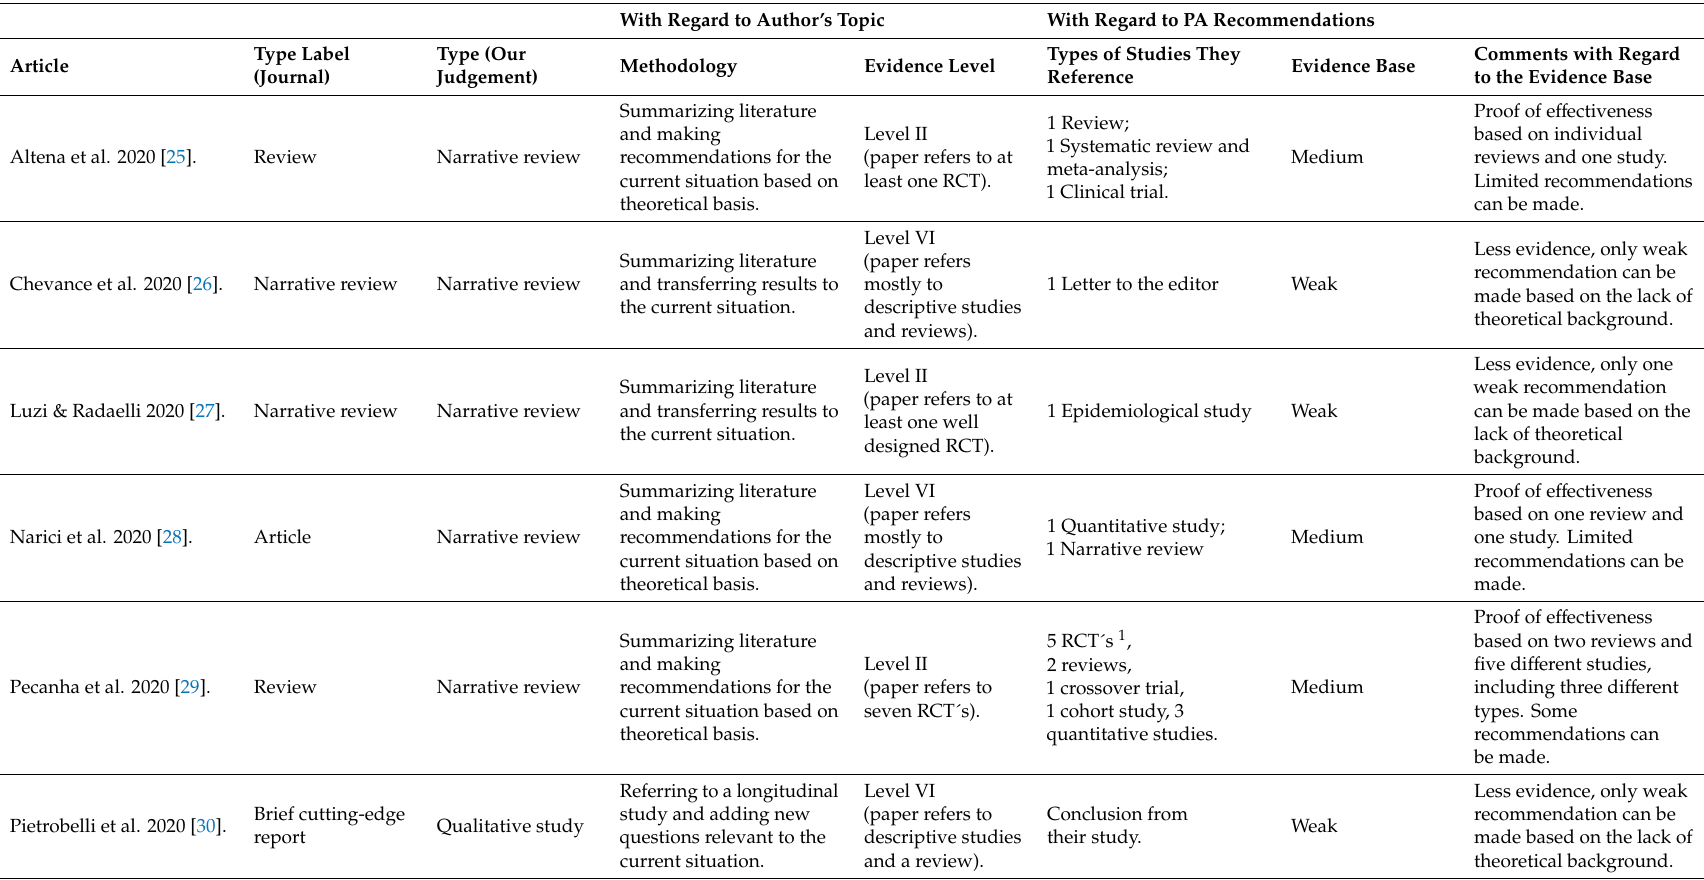
Table 2. Methodological quality of studies for “Staying Active” during COVID-19